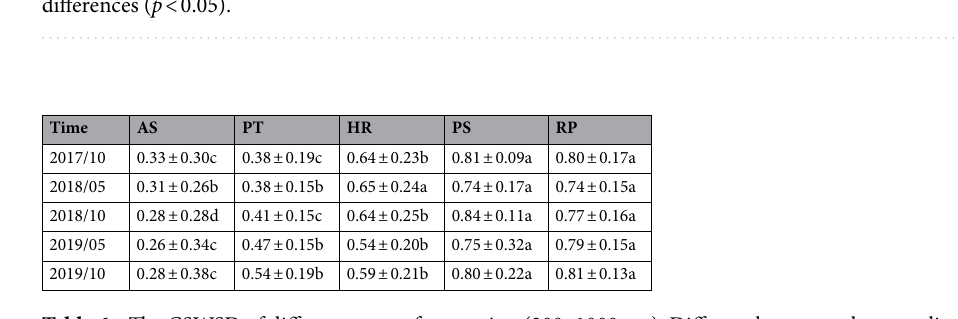
Table 6. The CSWSD of different types of vegetation (200–1000 cm). Different letters on the same line indicate significant differences ( p < 0.05).